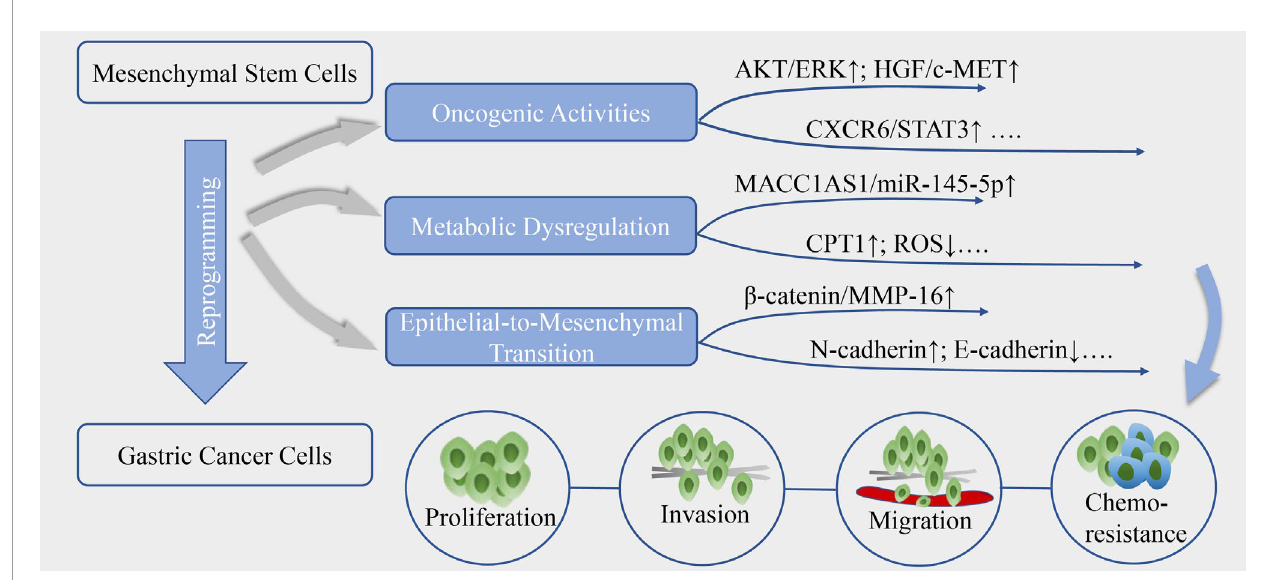
FIGURE 1 | The reprogramming of GC by MSC. MSC could reprogram the biological activities of gastric cancer cells, mainly through aberrantly activate oncogenic signals, metabolic reprogramming and epithelial-to-mesenchymal transition, contributing to cancer cells proliferation, invasion, migration and resistance to